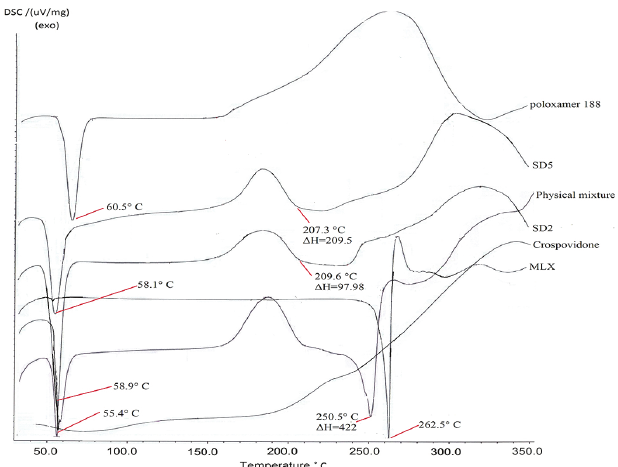
FIGURE 1 - The DSC thermograms of poloxamer 188, crospovidone, pure MLX, physical mixture of MLX and polymers and MLX SDs (SD2 and SD5).